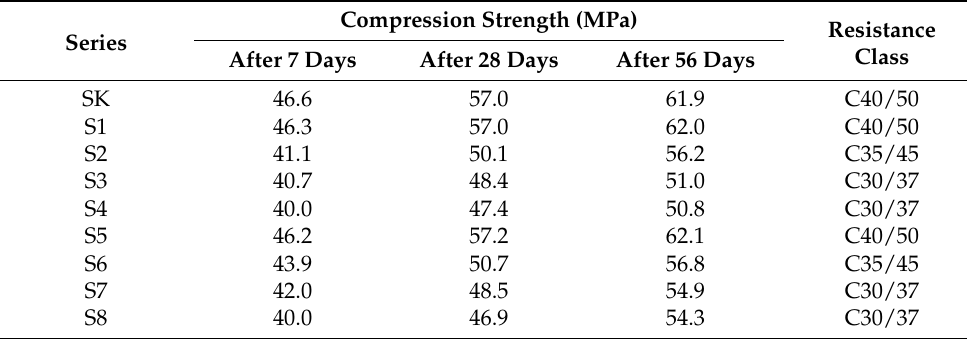
Table 4. Compressive strength of the tested concretes and strength